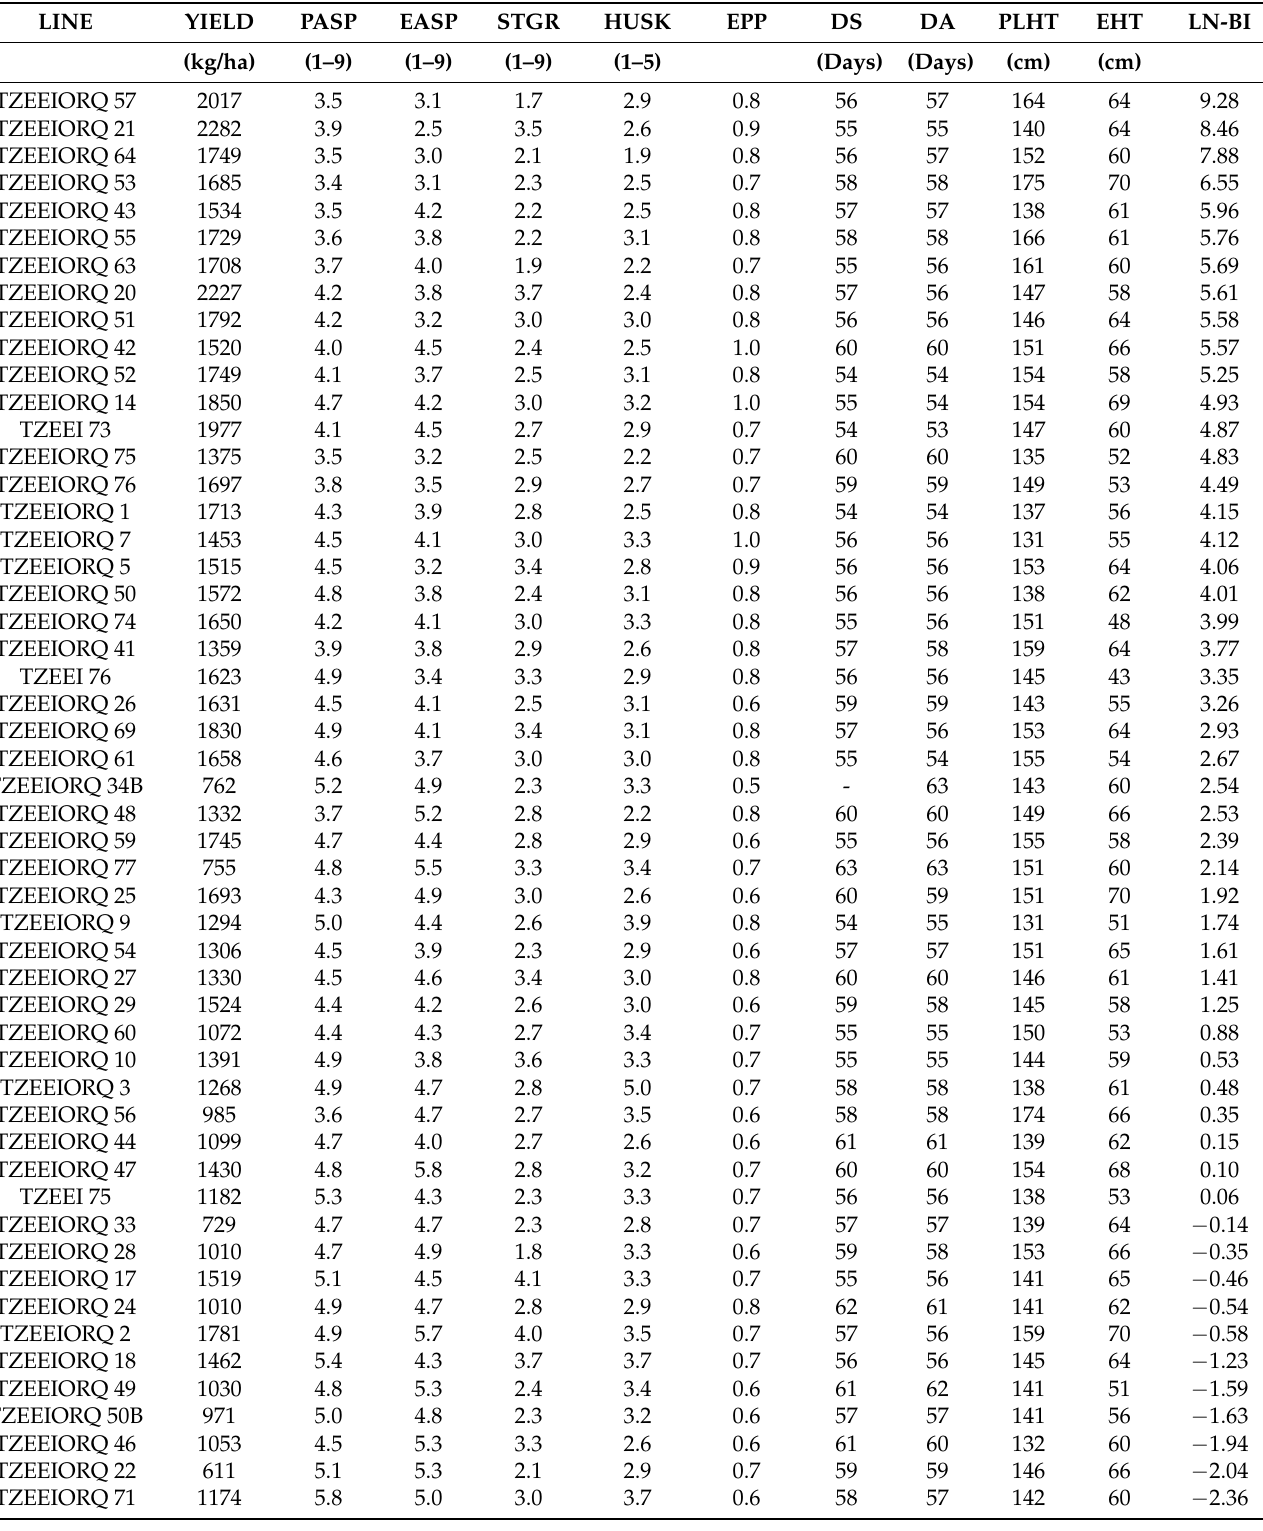
Table 5. Grain yield and other agronomic traits of 76 extra-early provitamin A/QPM inbreds with four checks evaluated across low-N environments at Ile-Ife and Mokwa between 2016 and 2017 in